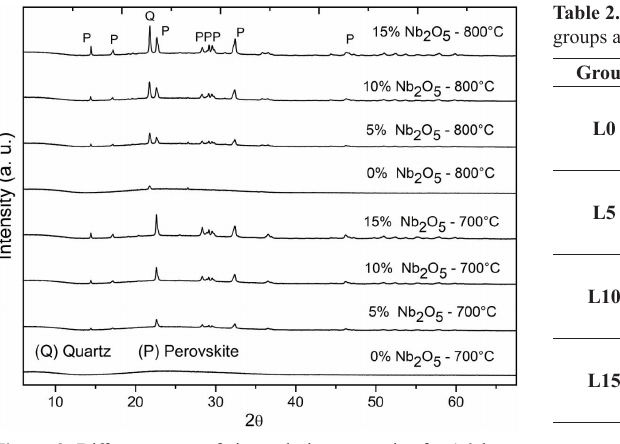
Figure 2. Diffractograms of sintered glass-ceramics for 1.0 h, at 700 and 800 ºC for different niobium pentoxide contents.